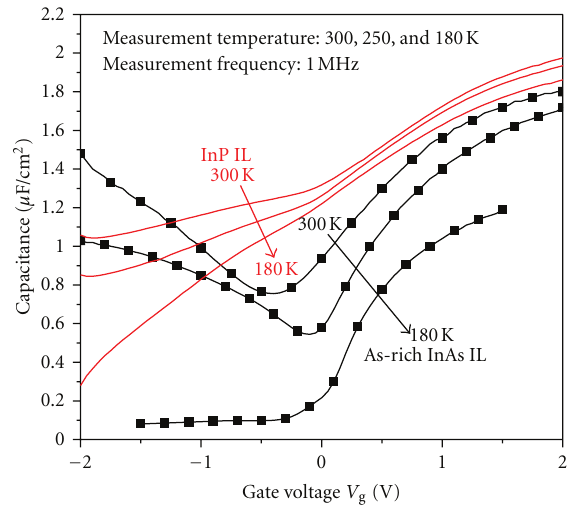
Figure 7: 1MHz temperature-dependent C - V characteristics of InAs MOS capacitor with respective InP or As-rich interfacial